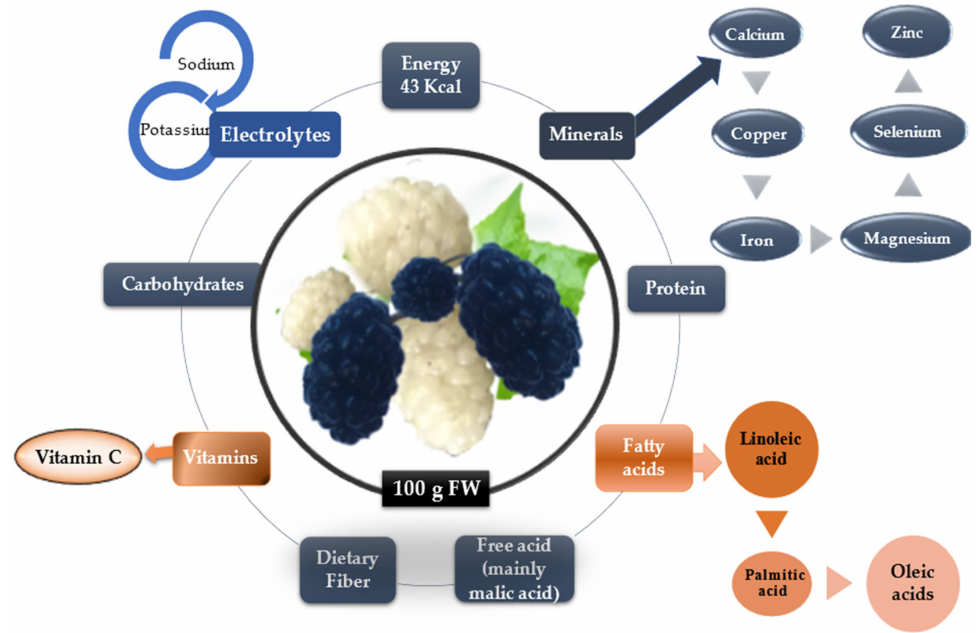
Figure 2. The nutrients components of mulberry